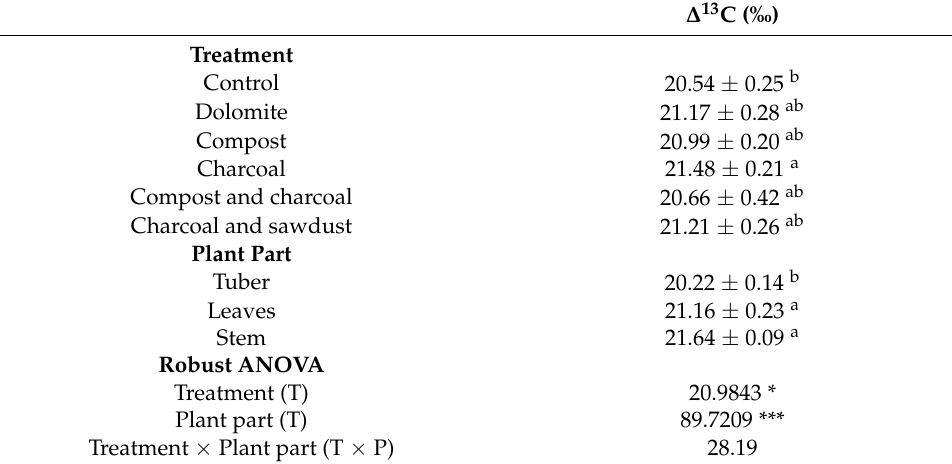
Table 4. Comparison of mean carbon isotope discrimination ( ∆ 13 C) in different soil amendment treatments and plant parts of cassava. Given are mean ± SE ( n = 4). Different letters indicate significant differences in treatment and plant part as revealed by robust two-way ANOVA followed by linear contrast post hoc test with associated p -values for treatment (T), plant part (P), and their interaction (T ×